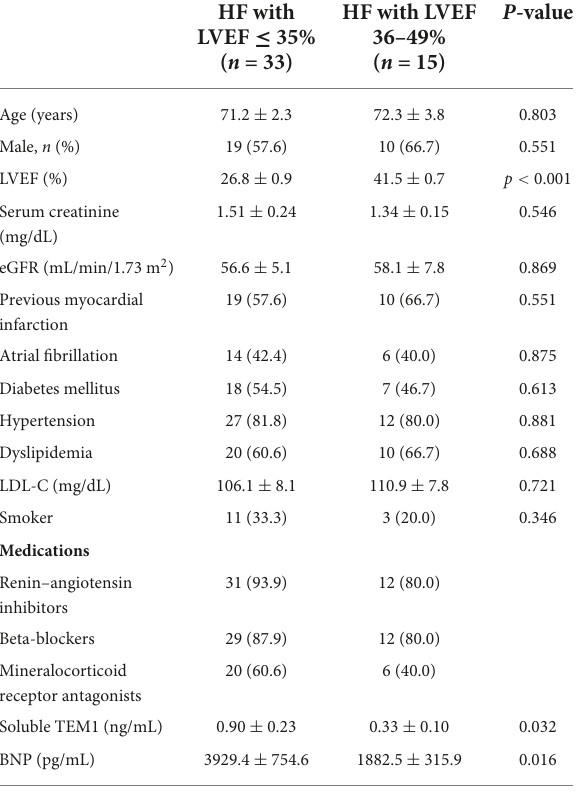
TABLE 2 Baseline characteristics and soluble TEM1 levels in HF